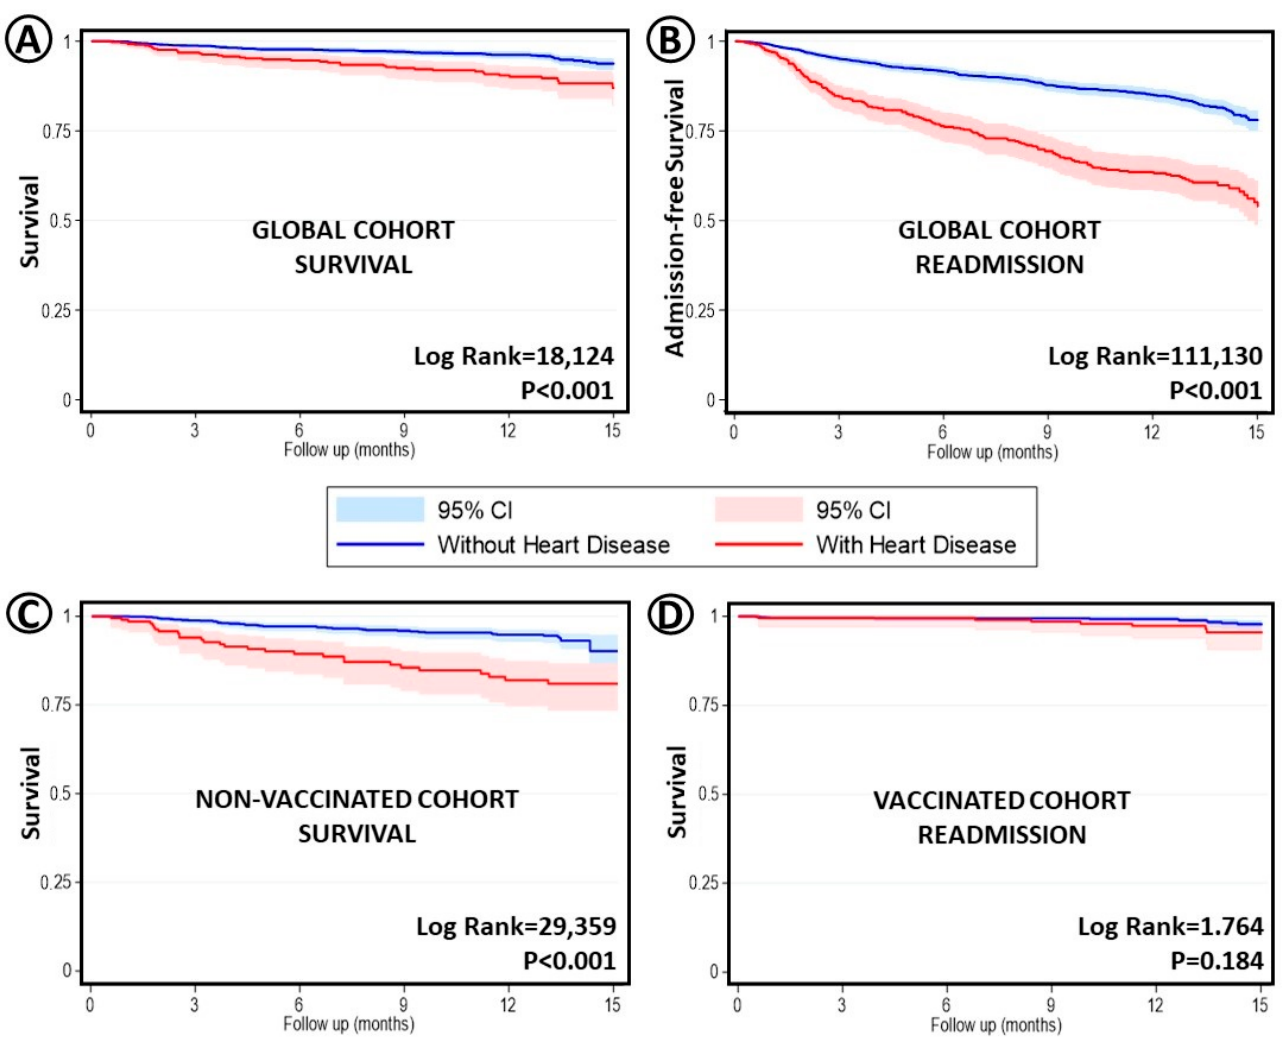
Figure 2. Kaplan–Meier curves unadjusted survival analysis, comparing no heart disease vs. any type of underlying heart condition. T 0 = Admission date. ( A ) Global cohort and survival. ( B ) Same comparison but regarding readmissions. ( C ) Cohort of patients not vaccinated (any dose) and survival. ( D ) Cohort of patients vaccinated (any dose) and survival.